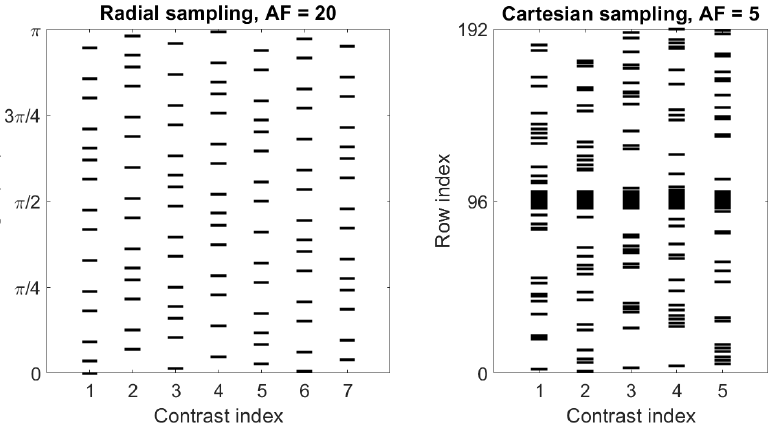
Figure 3. Sampling patterns of the angles of the sampled spokes of the radial simulation data with acceleration factor 20 ( Left ) and the indices of the sampled rows of the cartesian ex vivo data with acceleration factor 5 ( Right